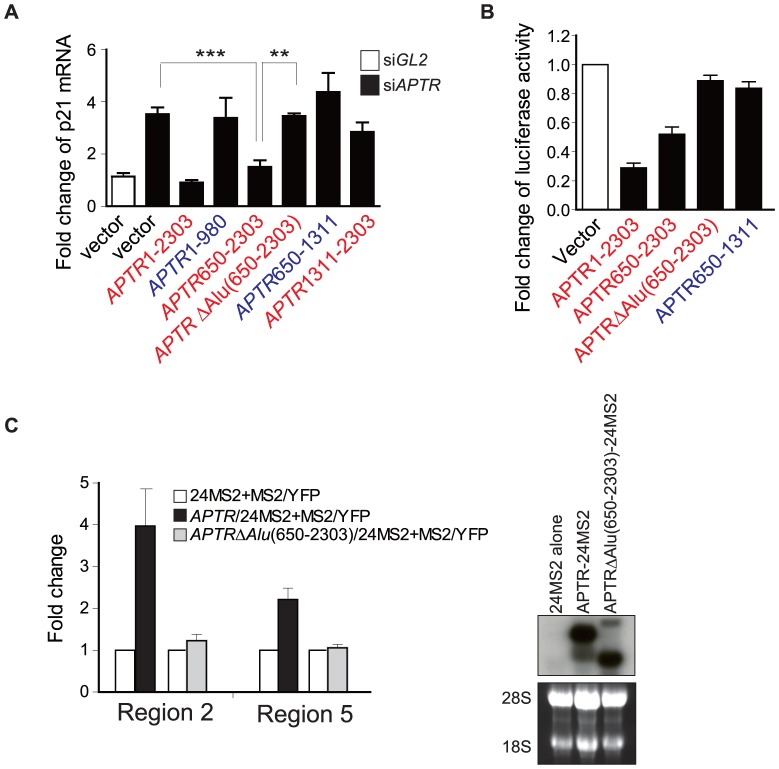
The embedded c-Alu and the 3′ end of APTR are each required for p21 suppression.(A) Q-RT-PCR of p21 mRNA after siAPTR#2 (black bars) and transfection of empty vector or vector expressing wild-type or mutant APTR in 293T cells. X-axis: empty vector or form of APTR expressed by transfected plasmid. Red represents the mutants that bind to PRC2. Blue represents the ones that do not bind to PRC2. Y-axis: fold change of p21 normalized to GAPDH relative to siGL2-transfected cells receiving empty vector (white bar). Mean ±s.e.m; n = 6, ***: P<0.0005. **: P<0.005. (B) Firefly luciferase activity of p21 promoter in cells transfected with empty vector or vector expressing wild-type or deletion mutants of APTR. Red represents the mutants that bind to PRC2. Blue represents the ones that do not bind to PRC2. Firefly luciferase activities were normalized to Renilla luciferase from co-transfected plasmid. (C) CLIP of MS2-APTR or MS2-APTRΔAlu(650–2303) or MS2 RNA alone (negative control) on two sites in the p21 promoter (2 and 5 as defined in Figure 3F). Y-axis: amount of specific DNA in the precipitate normalized to that in CLIP of MS2 RNA alone. Mean ±s.e.m., n = 6. Northern blot on the right with APTR cDNA (651–950), shows that the APTR fusion RNAs are expressed.